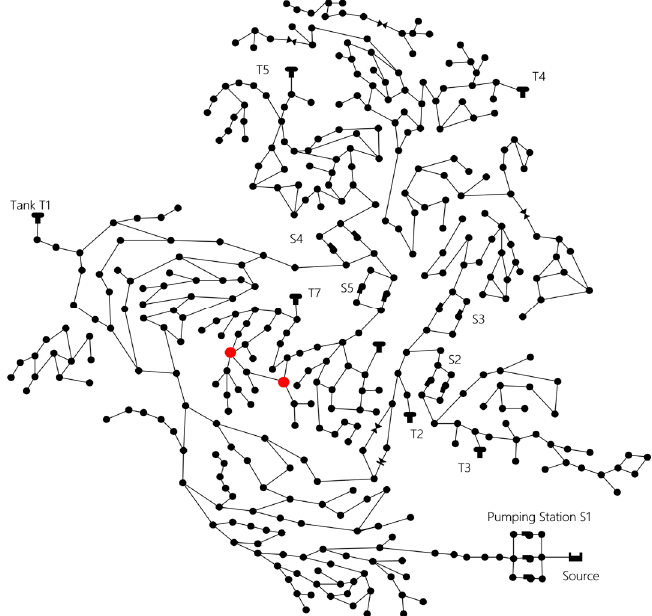
Figure 5. Structure of Network 2. The nodes with red marks are detection stations chosen Case 2.